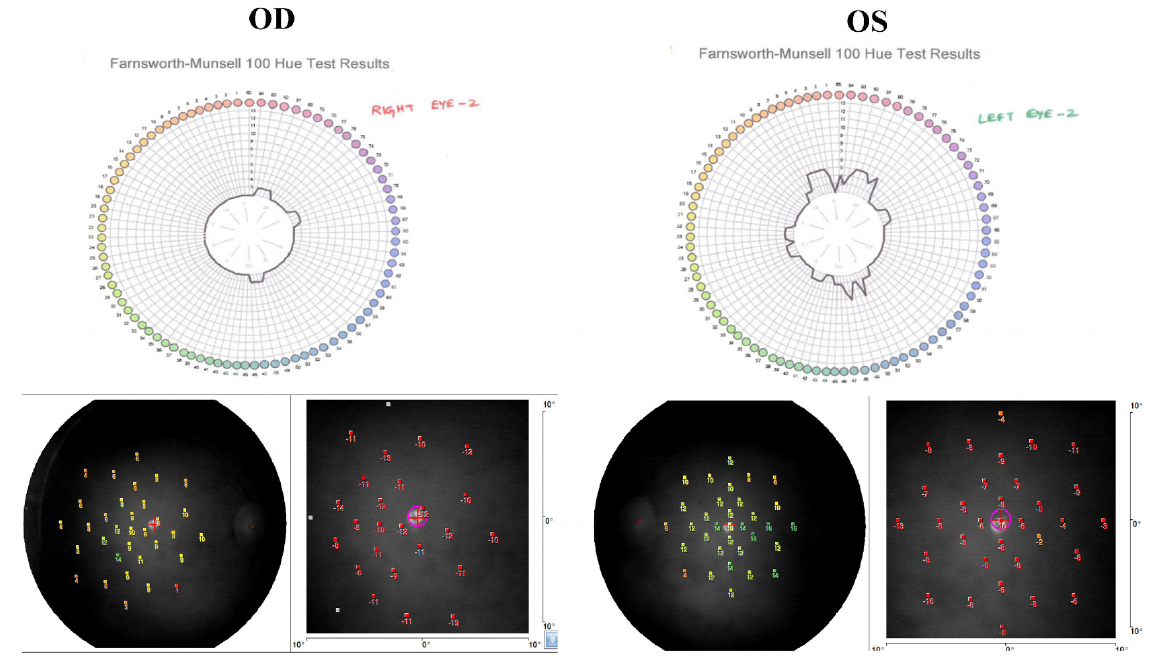
Figure 2: Post-oxygenation therapy; Farnsworth-Munsell 100 hue test and microperimetry